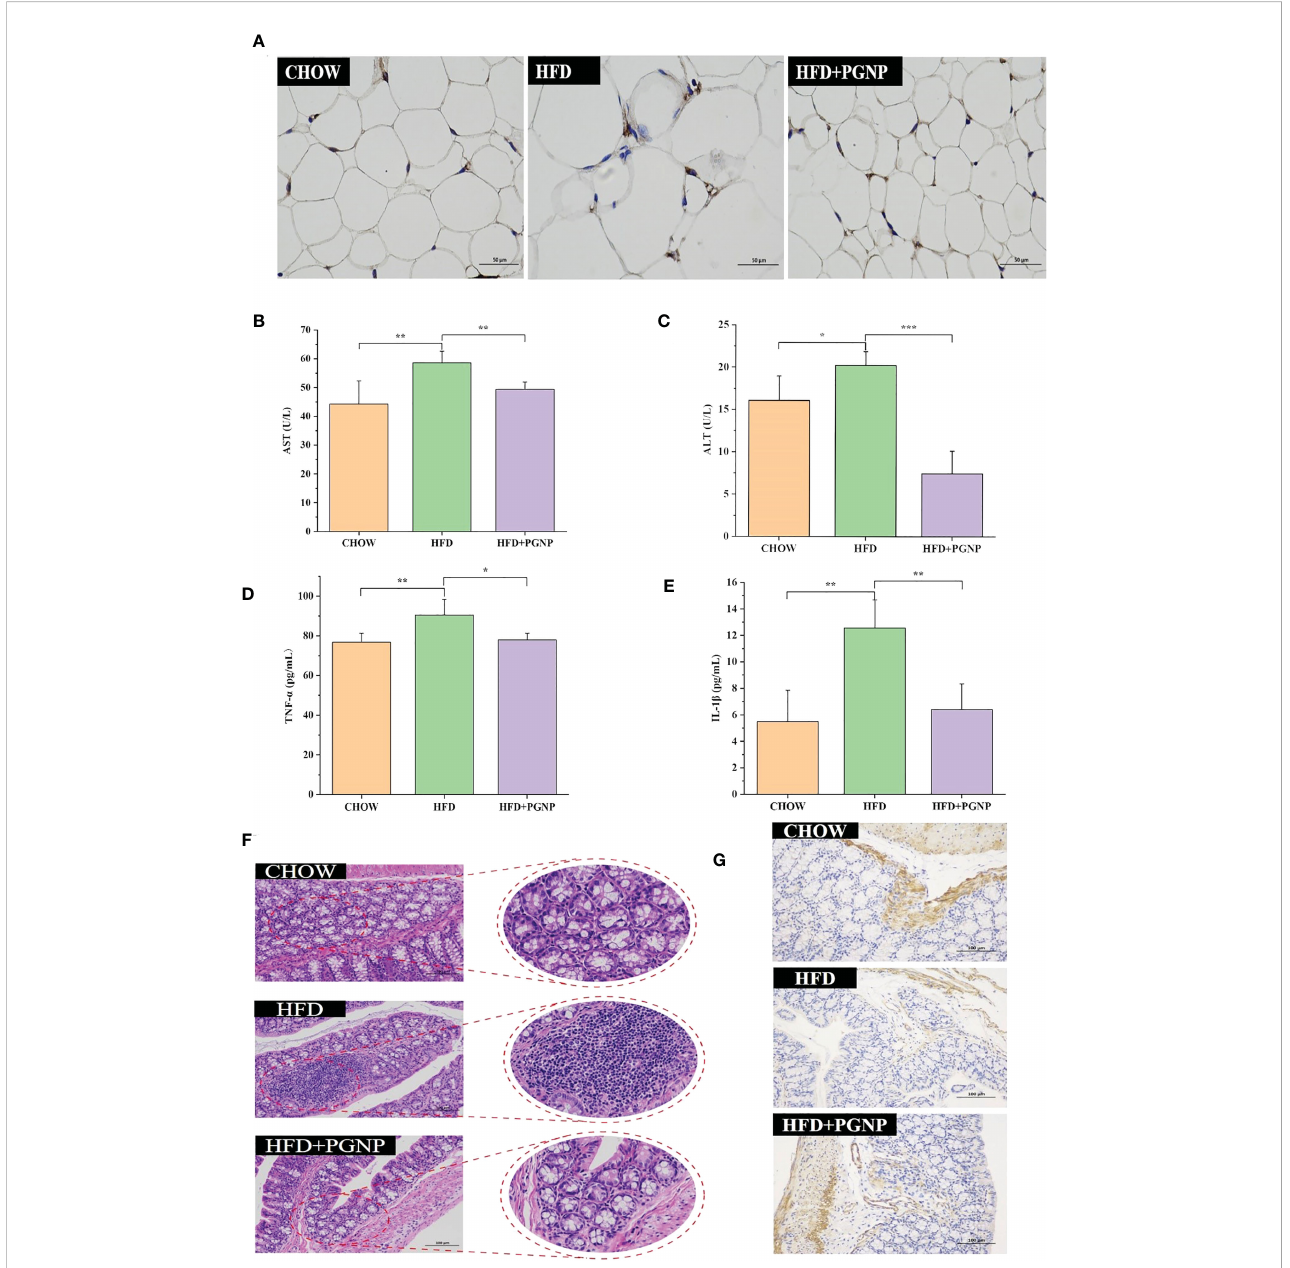
FIGURE 3 Effects of PGNP on lipid metabolism and chronic low-grade in fl ammation. Immunohistochemical staining of F4/80 expression (A) AST levels in serum (B) ALT levels in serum (C) TNF- a levels in serum (D) IL-1 b levels in serum (E) Colon tissue sections histologically stained with H&E (F) Immunohistochemical staining of ZO-1 expression (G) . *** P < 0.001, ** P < 0.01, * P <